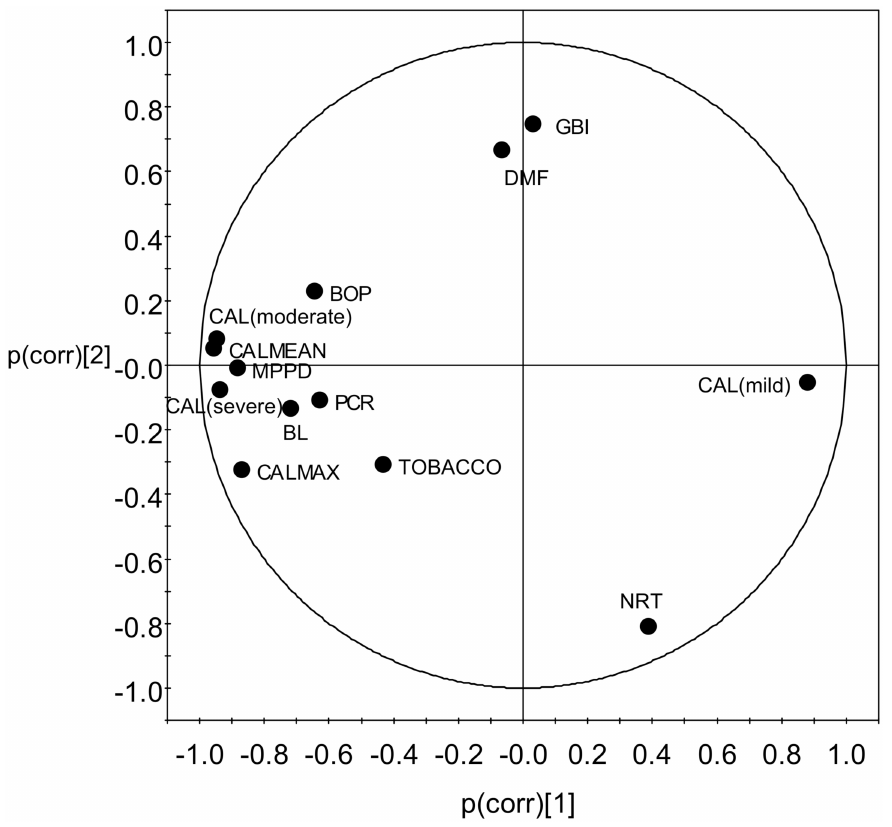
Fig 1. Loadings plot of the principal component analysis (PCA) performed on clinical variables of periodontitis. Loadingsare scaled so that the correlated variablescorrectly explainedby the components are found close together and near the correlationcircle. BL: boneloss; BOP: bleedingon probing;CAL: clinicalattachment loss, expressedas a mean (CALMEAN) or accordingto the severity of the loss (CALmild, CALmoderate, and CALMAX); DMF: decay missing filled; MPPD: mean pocket depth; NRT: number of residual teeth; PCR: plaquecontrol record; TOBACCO: smoking habits (for details see Materials and